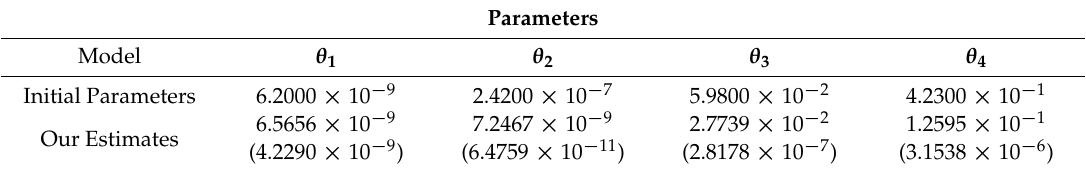
Table 4. Initial parameters and the means with standard errors in brackets of the 50 parameter estimates.